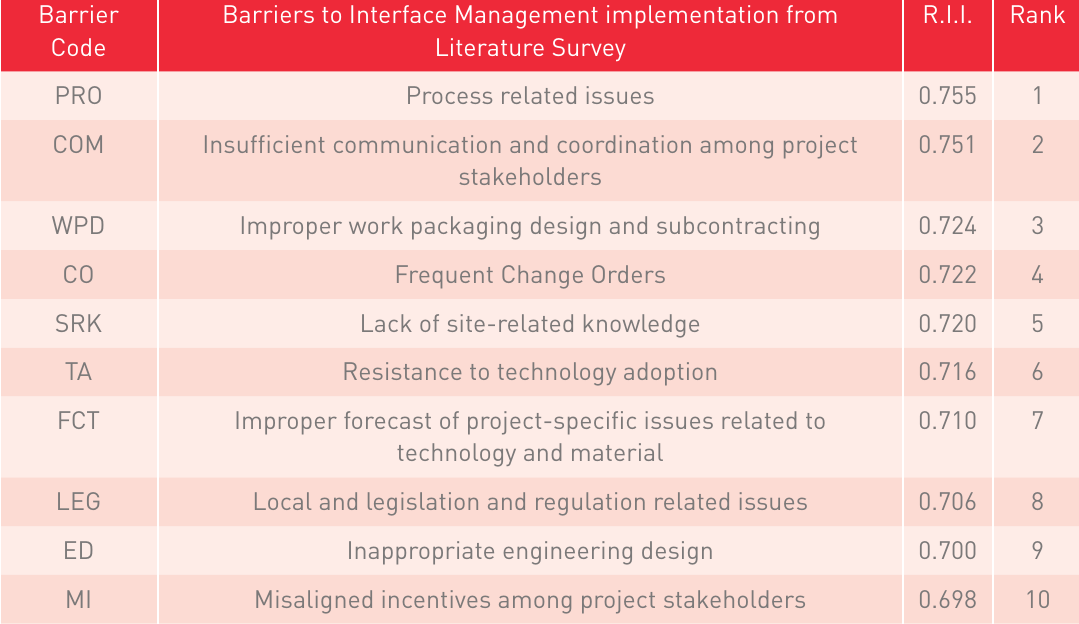
RII prioritized the top 10 Barriers to